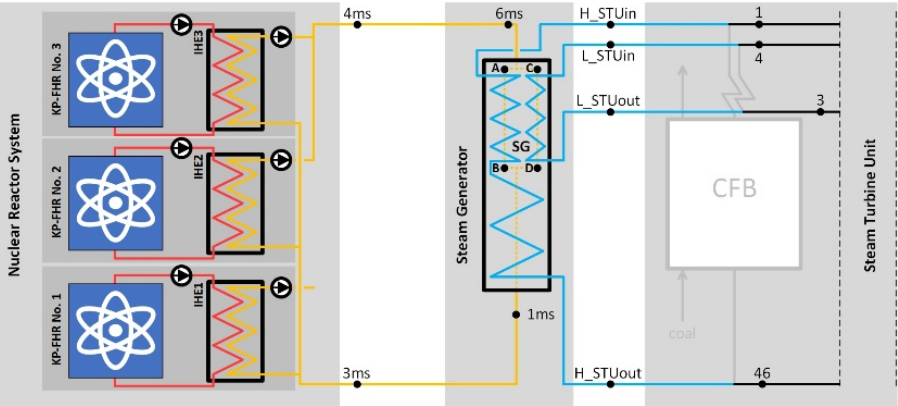
Figure 4. Integration diagram of 3 nuclear reactors with the steam turbine unit (Case REF_3NR).